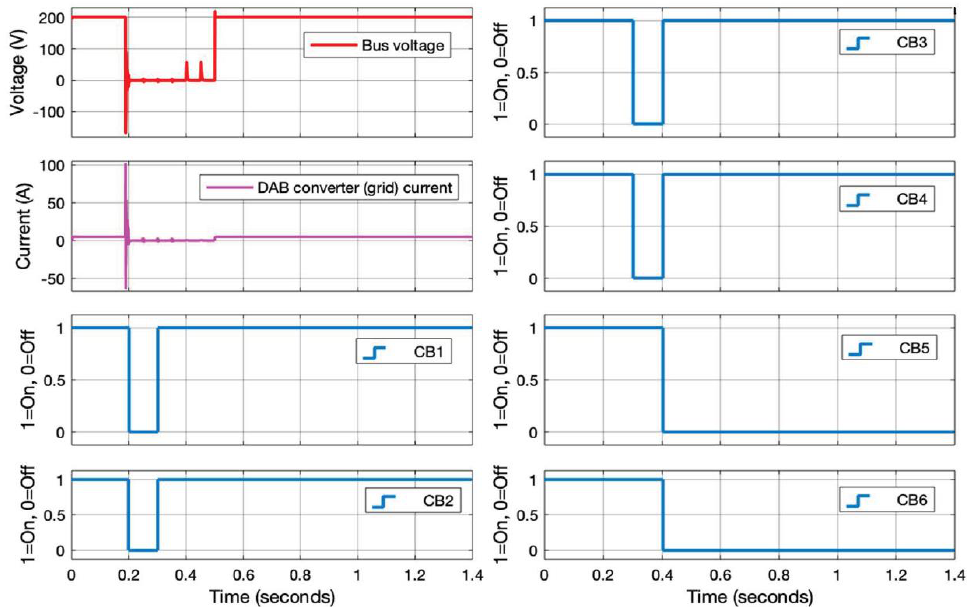
Figure 11. Line fault searching using a pair of the CBs across each line of the grid, the fault is found in Line-3 (see CB5 and CB6), where the faulty line is isolated and the grid is restored.